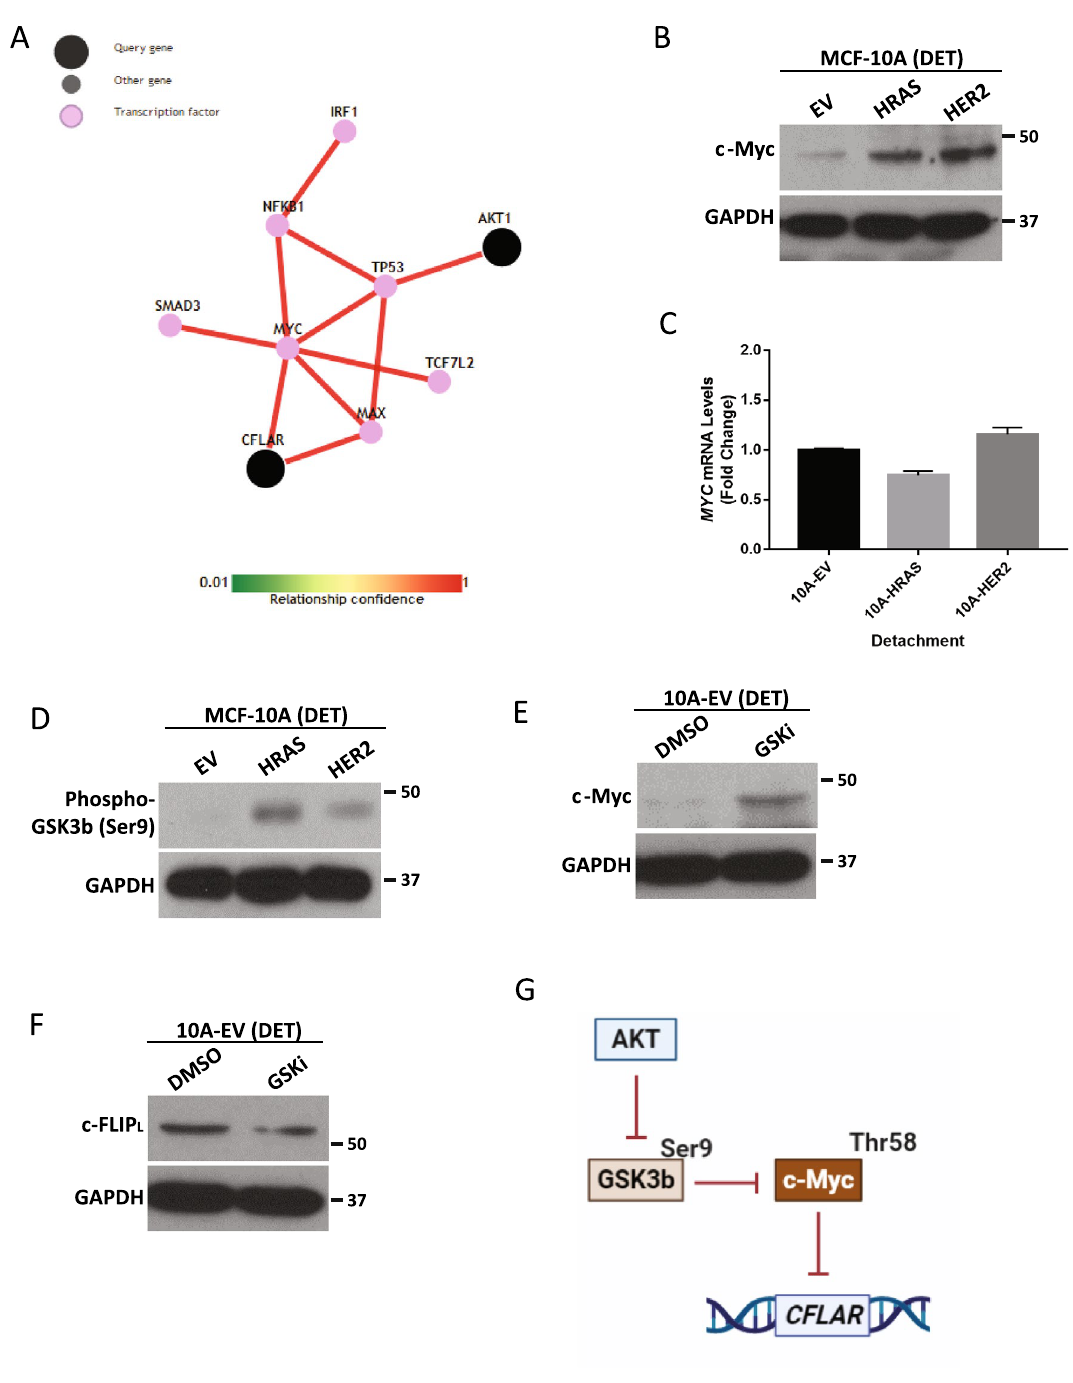
Figure 4. Transcriptional regulation of c-FLIP L during ECM-Detachment. ( A ) In-silico analysis of the transcriptional relationship between CFLAR and AKT1 using a pathway prediction tool (http:// pathw aynet. princ eton. edu/). ( B ) Measurement of c-Myc levels in oncogene overexpressing MCF-10A cells as compared to EV control. ( C ) Measurement of c-Myc transcript levels using RT-qPCR in oncogene overexpressing MCF- 10A cells as compared to EV control. ( D ) Measurement of GSK-3β activity by blotting for its phosphorylation at serine 9. ( E ) Inhibition of GSK-3β activity using 25 μM TDZD-8 (GSK-3β inhibitor) in 10A-EV cells. ( F ) Determination of c-FLIP L protein levels in 10A-EV cells after the inhibition of GSK-3β activity using 25 μM TDZD-8. ( G ) Schematic representation of transcriptional regulation of c-FLIP L by Akt. Graphs show representative data from a minimum of three biological replicates and all western blotting experiments were independently repeated a minimum of three times with similar results. Cells were grown in ECM-detached conditions in all panels. Statistical significance was determined using Student’s two-tailed t test. Error bars show standard